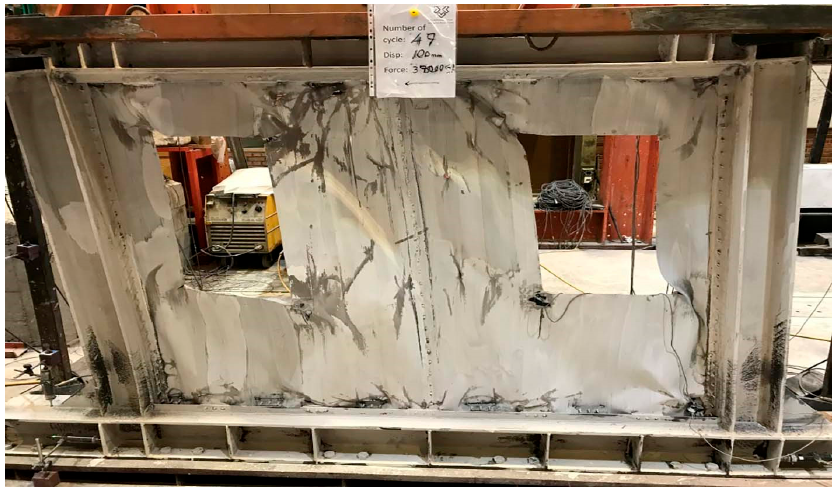
Figure 11. Specimen 2 at the end of loading.